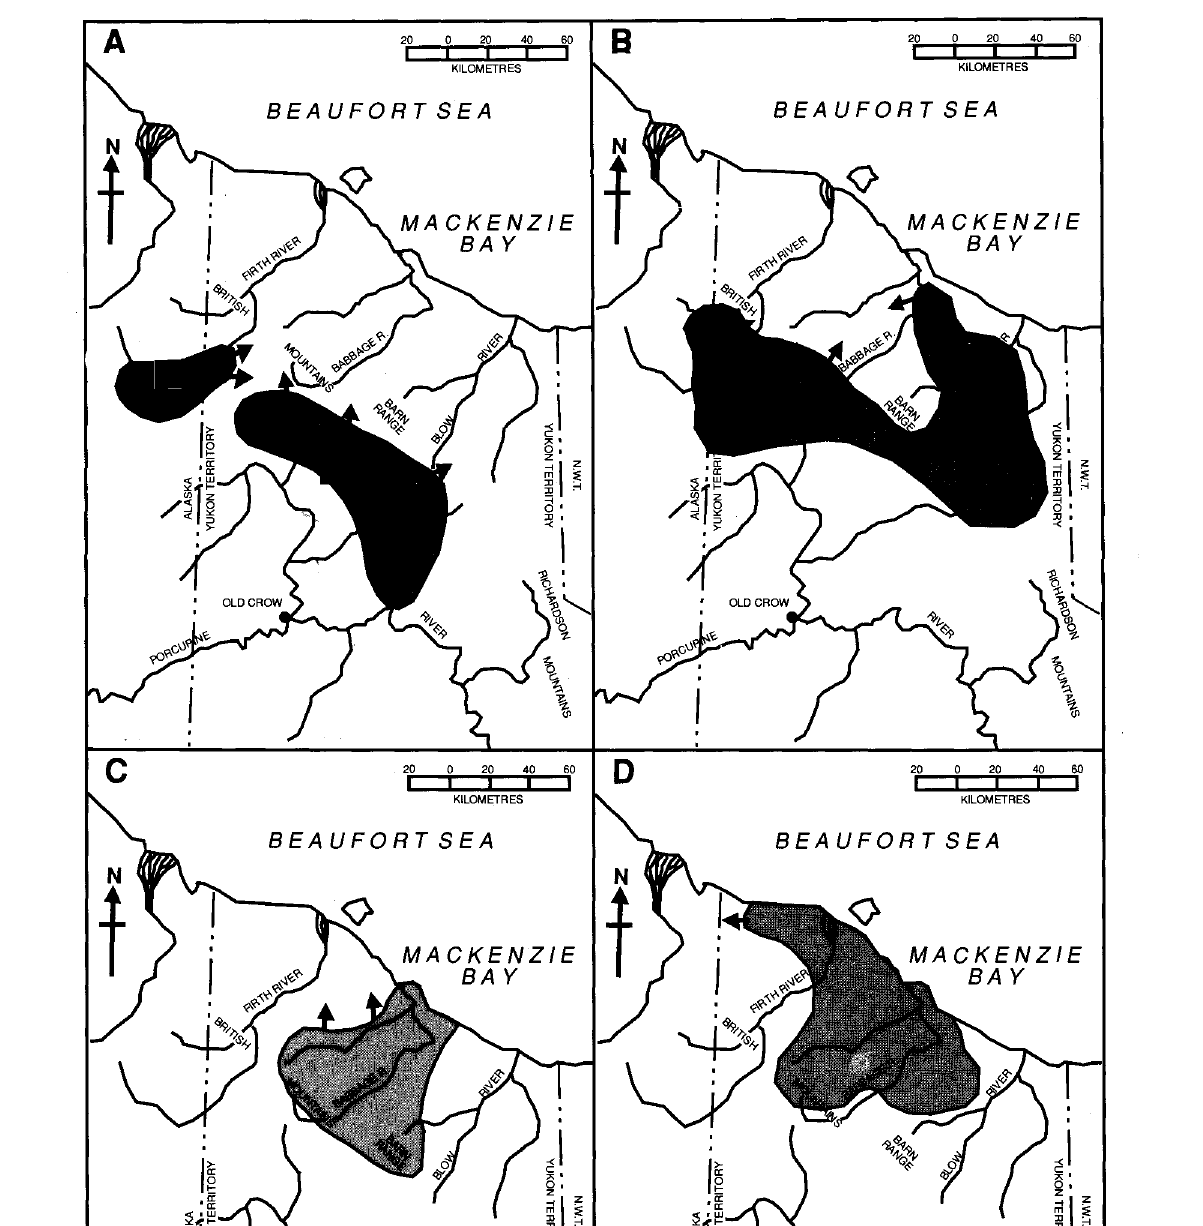
Figure 3.12. General distribution and direction of movement of male caribou in northern Yukon in late May (A), early June (B), mid June (C), and late June